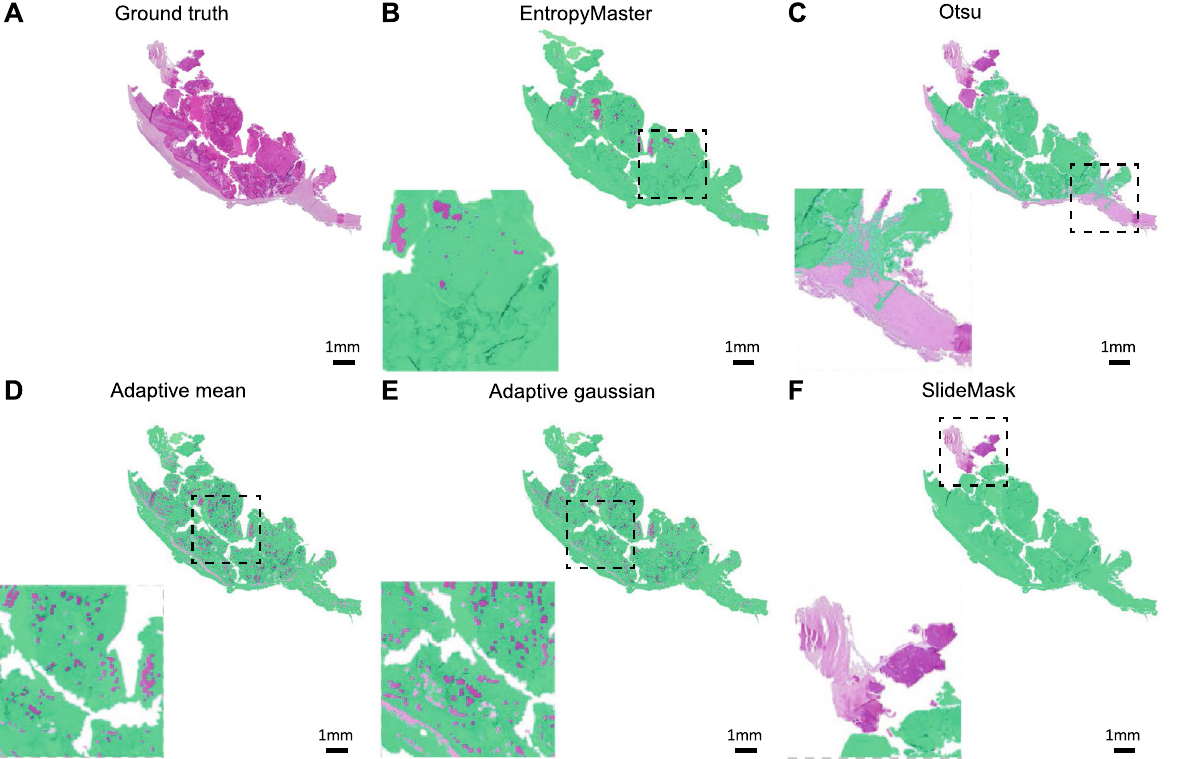
Figure 3. Comparison of results of 5 masking methods for a randomly selected H&E-stained whole-slide image. ( A ) Expert generated annotation (ground truth) using Qupath Software (Version 0.3.2) 43 . ( B ) Our EntropyMasker method. ( C ) Otsu’s method. ( D ) Adaptive method where the threshold value is the mean of neighborhood area. ( E ) Adaptive method where the threshold value is the weighted sum of neighborhood values where weights are a gaussian window. ( F ) slideMask method. All the generated tissue masks are overlaid by pseudocolor